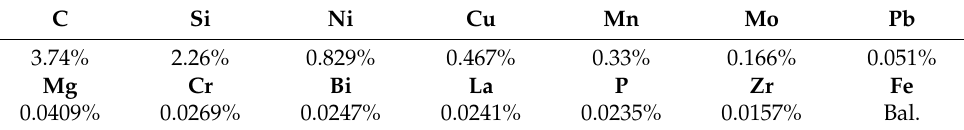
Table 3. Chemical composition of ADI workpiece.